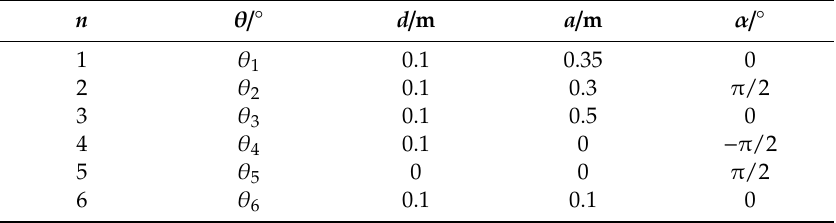
Table 10. The DH parameters of Bot 1